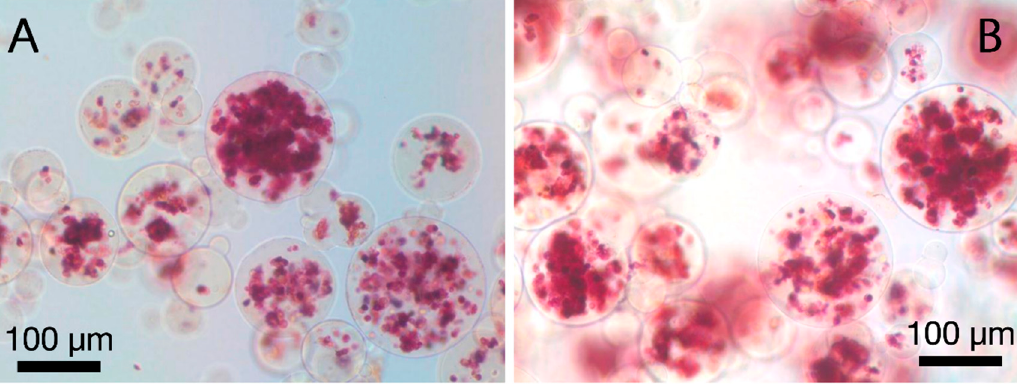
Figure 3. Alkaline phosphatase activity in basal maintenance medium ( A ) or osteogenic differentiation medium ( B ). There was no observable difference between groups.